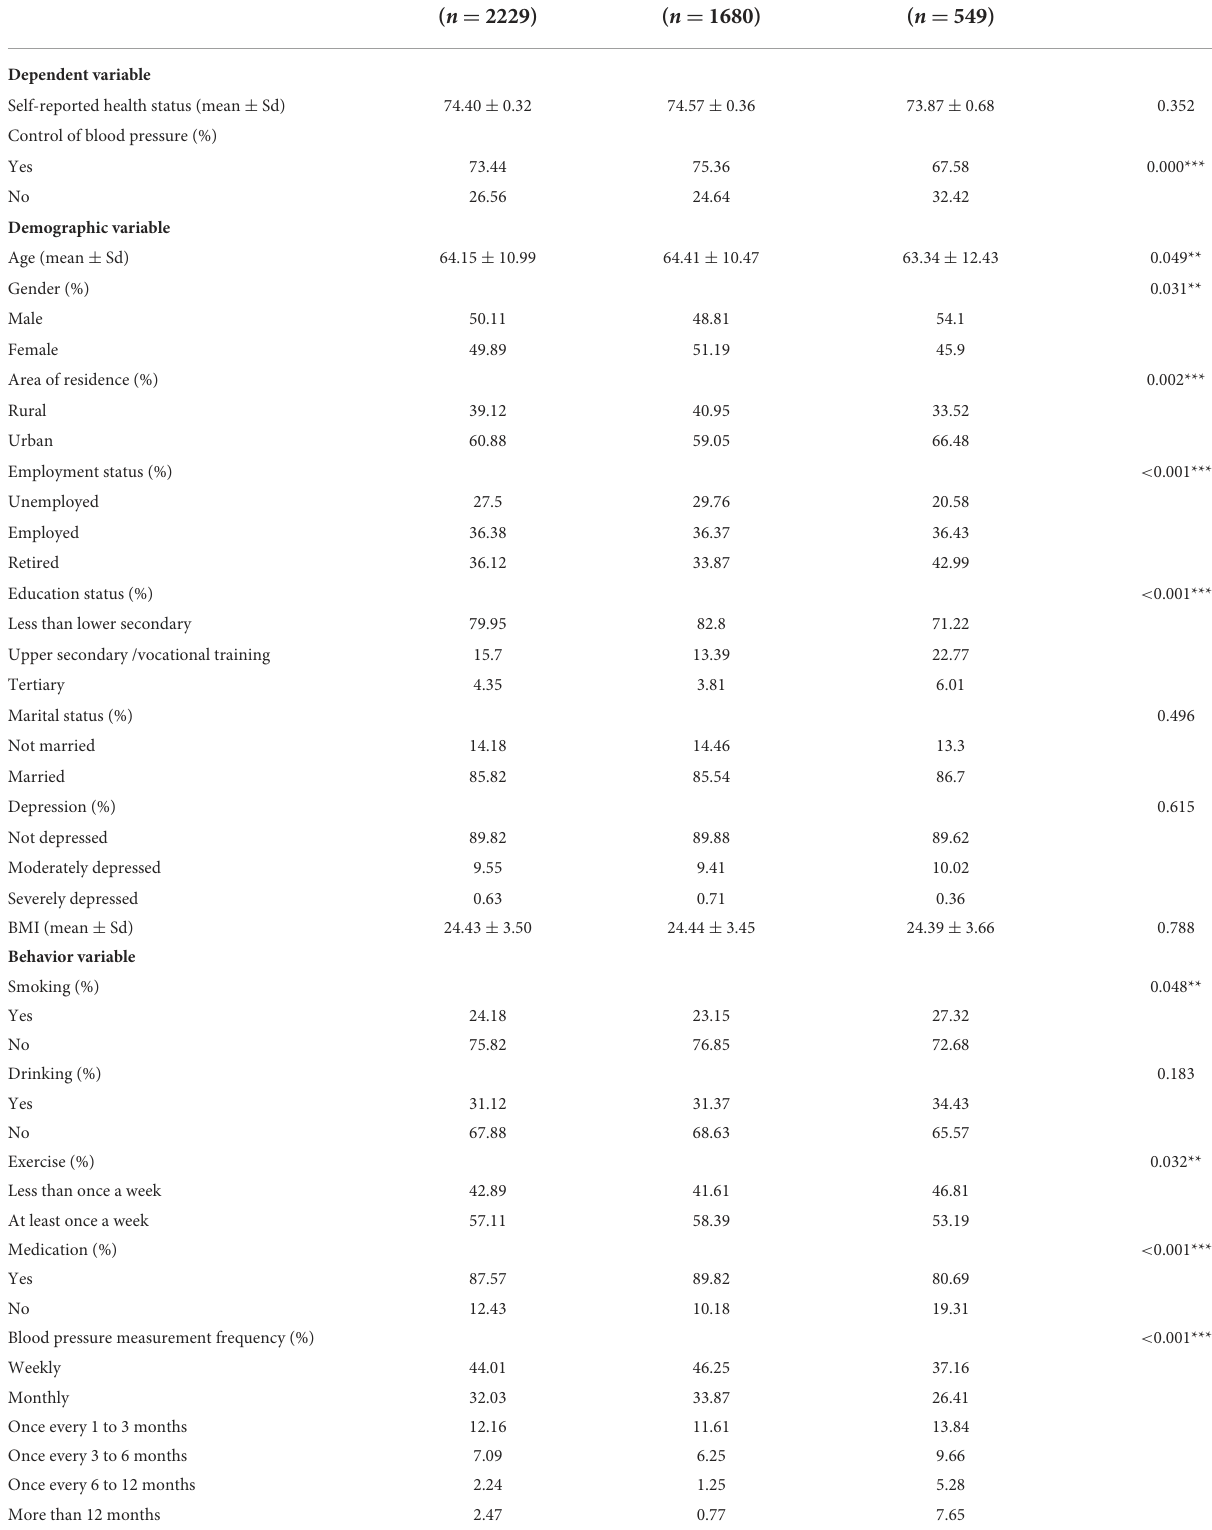
TABLE 2 Sample characteristics of